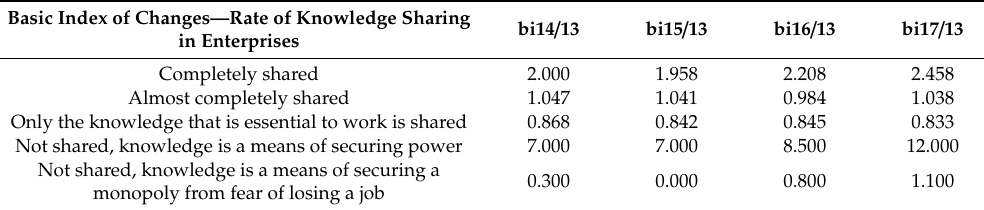
Table 5. Basic index of changes—rate of knowledge sharing in